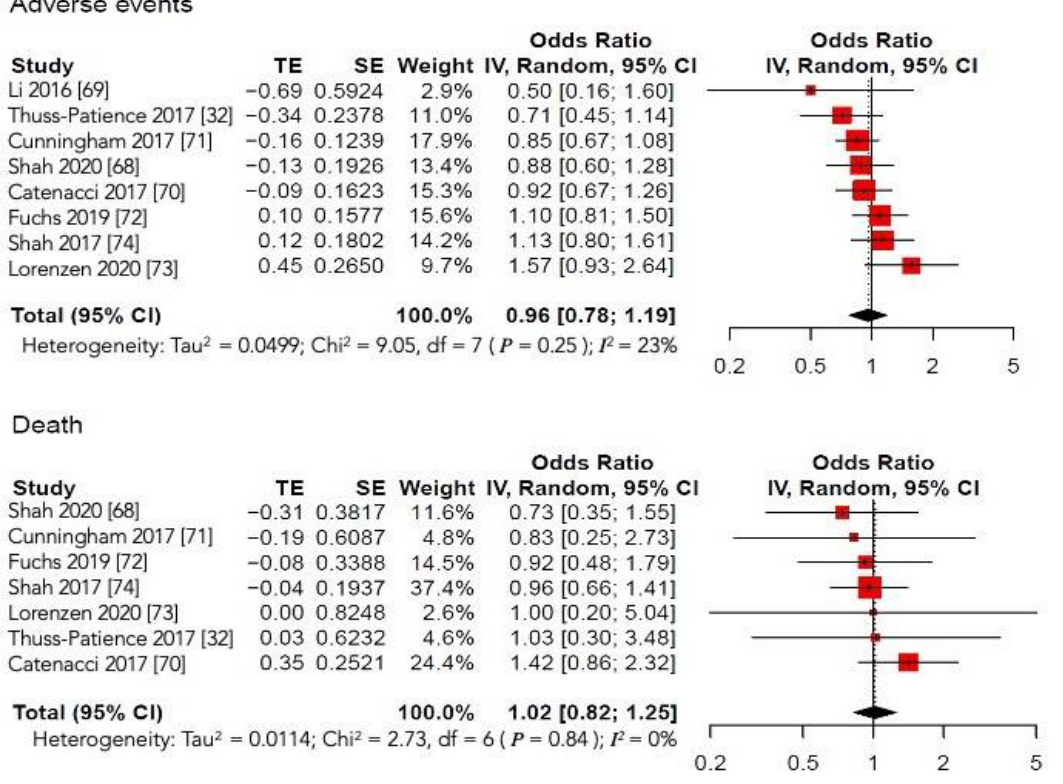
Figure 6. Forest plots of comparison: molecular-targeted therapy alone/plus chemotherapy versus chemotherapy alone/placebo. Secondary analyses; outcome: serious adverse effects and